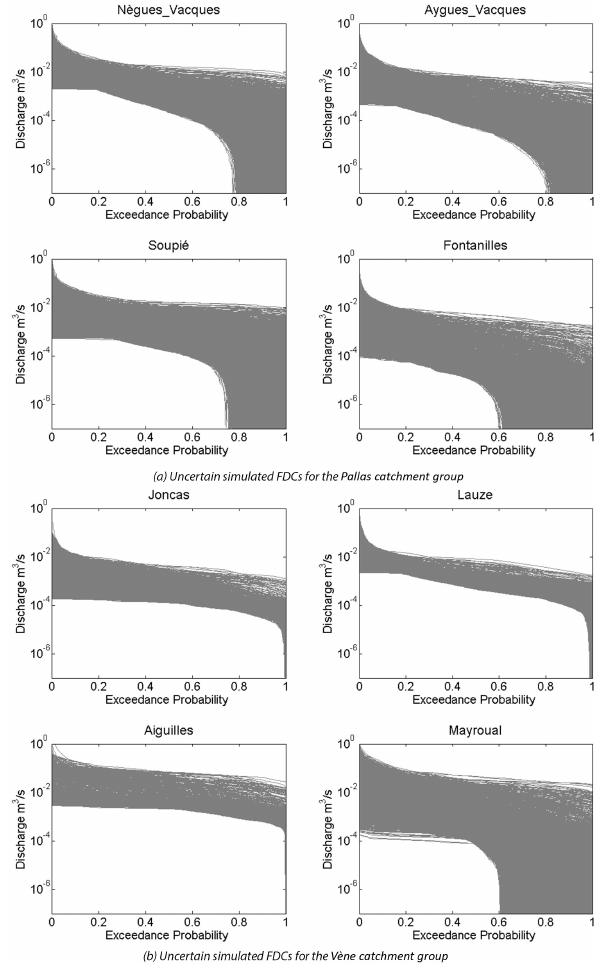
Figure 5. Simulated uncertain FDCs for the ungauged catchments based on model parameters regionalization.